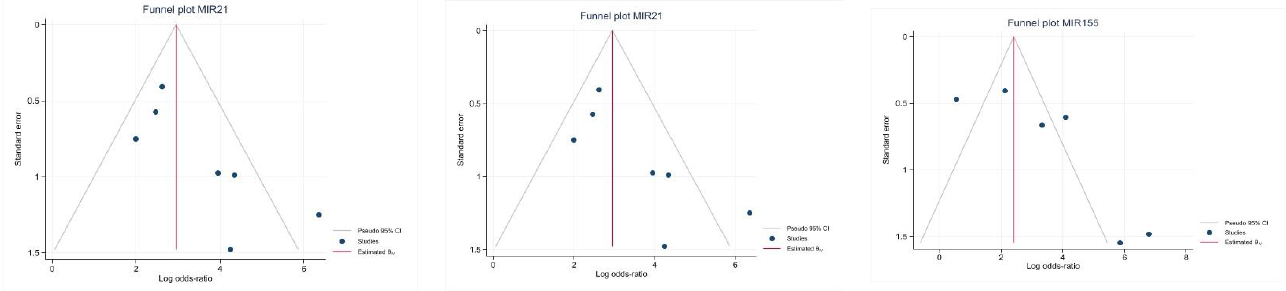
Figure 6. Evaluation of publication bias of all reported microRNAs presented as funnel plots.